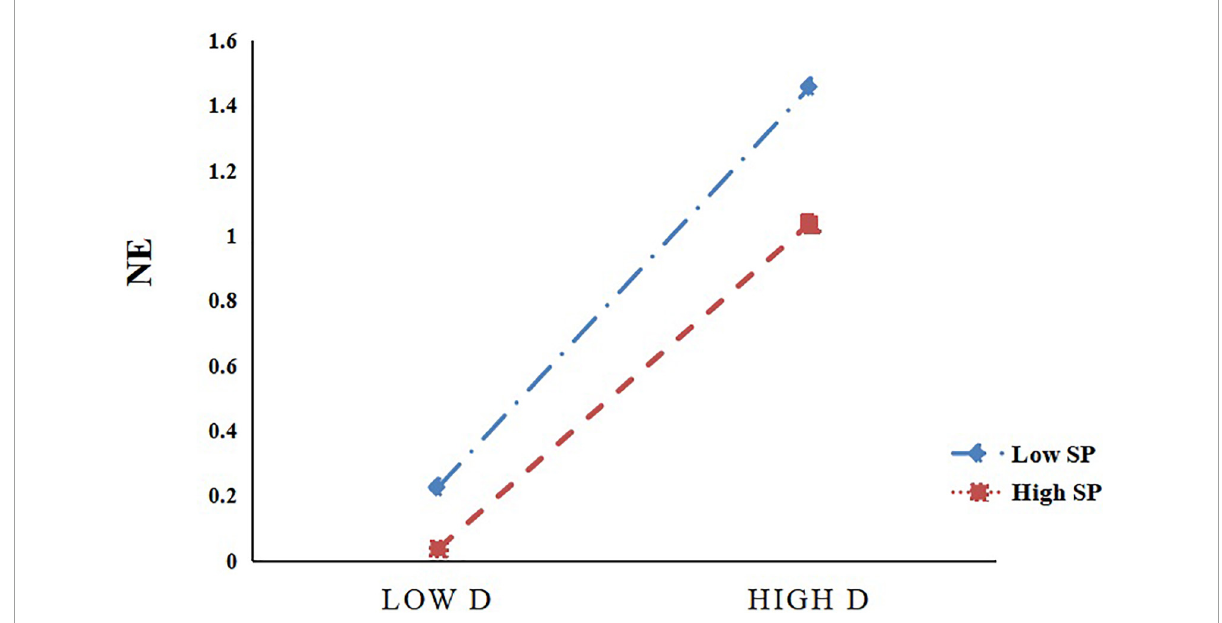
FIGURE3 Parental support as a moderator between catastrophising and negative emotions ( N = 401, where D is catastrophising, SP is parental support, NE is negative emotions, and NSSI is non-suicidal self-injury).